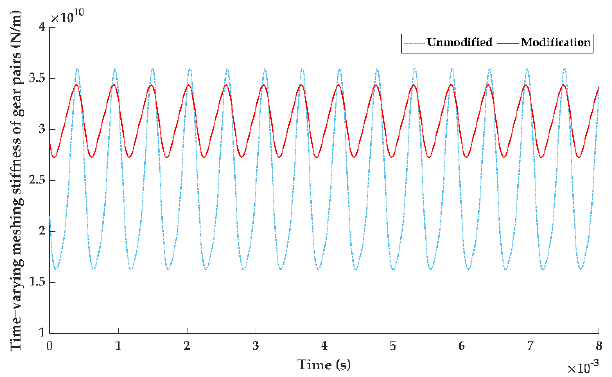
Figure 18. TVMS curve at a load of 300 N·m.